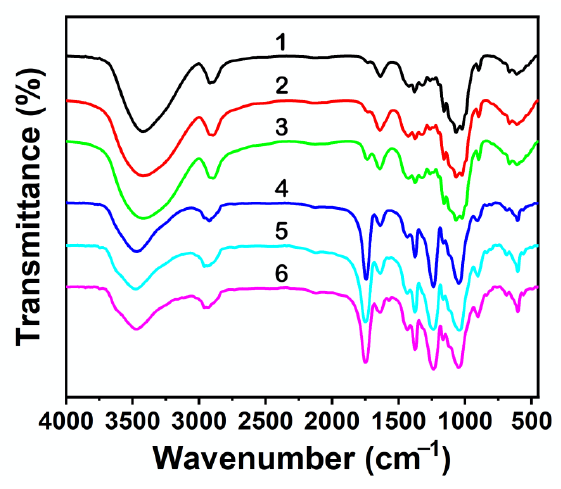
Figure 5. FTIR spectra of cellulose regenerated from EMIMCl solutions with 2 wt% cellulose content. Acetylation was carried out at 60 °C in the presence of 0.5 equivalent of Ac 2 O (4, dark blue line), 1 equivalent of Ac 2 O (5, light blue line), or 1.5 equivalents of Ac 2 O (6, pink line), followed by the addition of 10 mL of H 2 O to promote the EMIMCl- to EMIMCl·HOAc-based DESs transition and cellulose precipitation. The FTIR spectra of precipitated cellulose obtained upon the addition at 60 °C of 1 equivalent of AcOH (1, black line), 2 equivalents of AcOH (2, red line), or 3 equivalents of AcOH (3, green line) were also included for comparison.